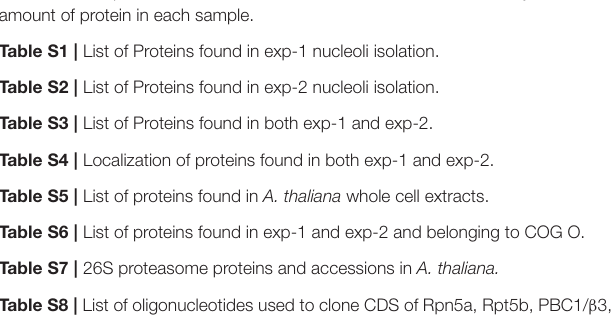
Figure S1 | A. thaliana nucleolar proteomes. (A) Venn diagram of A. thaliana of the overlaps of nucleolar proteomes from Palm et al. (2016) (blue), Pendle et al. (2005) (purple) and the present study (green). (B) Histogram showing the subcellular distribution of identified nucleolar proteins from Arabidopsis leaves according to Palm et al. (2016). Each protein can be localized in only one of the following categories: Cytosol or Nucleus or Nucleus and Cytosol or Nucleolus or Nucleolus and Cytosol or Nucleolus and Nucleus or Nucleolus and Nucleus and Cytosol. Figure S2 | Analysis GO (Gene Ontology) and COG (Cluster of Orthologous Genes) of proteins found in the nucleolus. (A) The Table Shows values for the five top GO categories for proteins identified in nucleolar fractions. No, Nucleolar proteins; WCE, Whole Cell Extract proteins. P -values and adjusted p -values, obtained with a Fisher test, are provided to indicate significant enrichment of specific proteins in the nucleolus compared to proteins detected in WCE. (B) The bar graph shows the percentage of each COG categories of proteins identified in the nucleolus. The GO and COG analysis were performed using the website servers http://www.genome.jp/tools/kaas/ and https://www.ncbi.nlm.nih.gov/ COG/ respectively. Figure S3 | Subcellular location of 26S proteasome proteins in A. thaliana (A) Scheme of the 26S proteasome complex showing the 19S Regulatory Particle (RP) and the 20S Core Particle (CP). In blue are represented protein subunits identified in both replicates (exp-1 and exp2) and in orange protein subunits only present in one of the replicate (exp1 or exp-2). In gray are indicated protein subunits non-identified in the nucleolar fractions. (B) Immunolocalization of Rpn5a-GFP, GFP-Rpn5a, PBC1/ β 3-GFP, GFP-PBC1/ β 3, Rpt5b-GFP, GFP-Rpt5b, and PBG1/ β 7-GFP and GFP-PBG1/ β 7 fused proteins in protoplasts of A. thaliana . The green signal shows the localization of Rpn5a, PBC1/ β 3, Rpt5b, and PBG1/ β 7 proteins. The red signal shows the signal emitted by the nucleolar marker Fibrillarin fused to mCherry ( Palm et al., 2016). AUF corresponds to auto fluorescence signal. Scale bar 5 µ m. Figure S4 | Immuno-localization of Rpn10 in root tip cells from WT FIB2:YFP plants. Arrows point subnucleolar structures called nucleolar cavities (NoC). Green fluorescence of the Fib2:YFP, is used to visualize nucleolus and DAPI staining to visualize nucleoplasm. Figure S5 | Western blot analysis of nuclear and cytoplasmic protein fractions. Specific antibodies were used to detect nuclear (Histone H3) or cytoplasmic (PRXII) proteins. NUC1 detection serves to verify the absence of NUC 1 protein in nuc1.2 mutant plants. Membrane was stained with Ponceau-S to verify similar amount of protein in each sample. Table S1 | List of Proteins found in exp-1 nucleoli isolation. Table S2 | List of Proteins found in exp-2 nucleoli isolation. Table S3 | List of Proteins found in both exp-1 and exp-2. Table S4 | Localization of proteins found in both exp-1 and exp-2. Table S5 | List of proteins found in A. thaliana whole cell extracts. Table S6 | List of proteins found in exp-1 and exp-2 and belonging to COG O. Table S7 | 26S proteasome proteins and accessions in A.